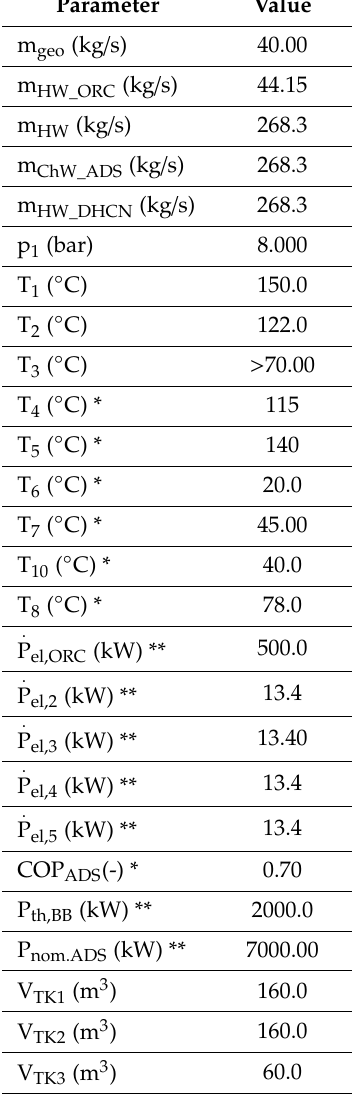
Table A2. Main thermodynamic and design input parameters.